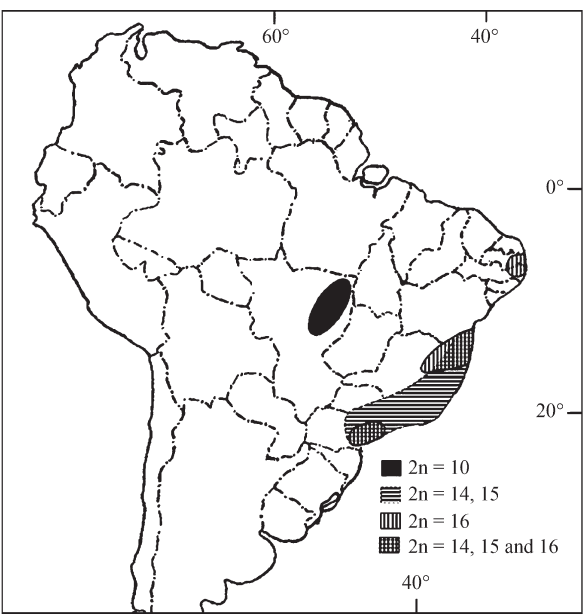
Figure 4 - Distribution of Akodon with 2n = 10; 2n = 14,15 and 2n = 16, summarized from Yonenaga-Yassuda (1979); Maia and Langguth (1981); Rieger et al . (1995); Sbalqueiro and Nascimento (1996); Fagun- des et al . (1998); Silva and Yonenaga-Yassuda (1998); Geise et al .